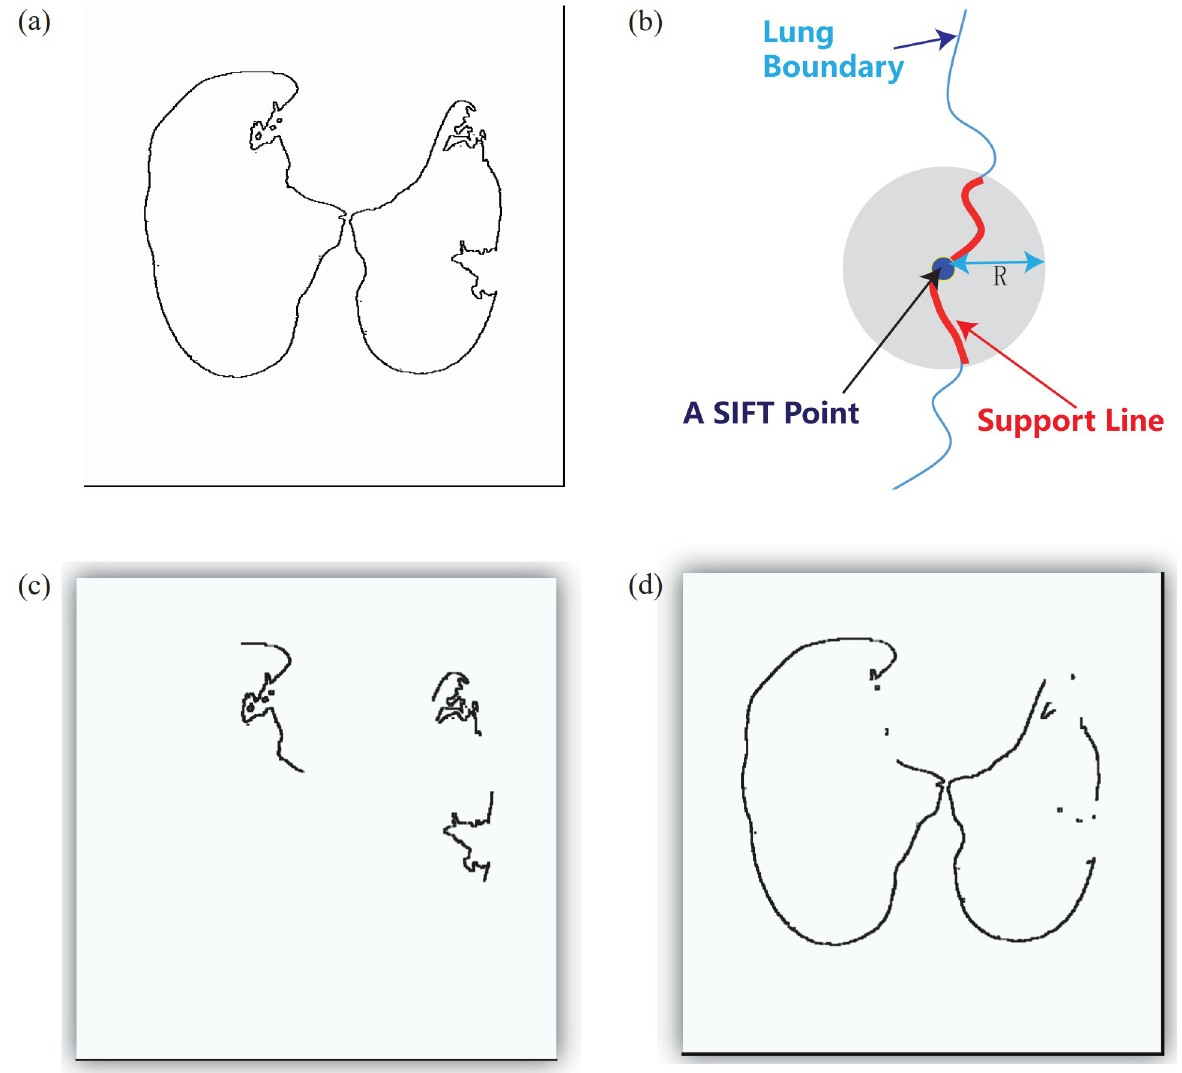
Fig 4. Supportive boundary lines and related results. (a) Whole lung boundary; (b) algorithm chart of the supportive line; (c) detected supportive lines; and (d) rest of the